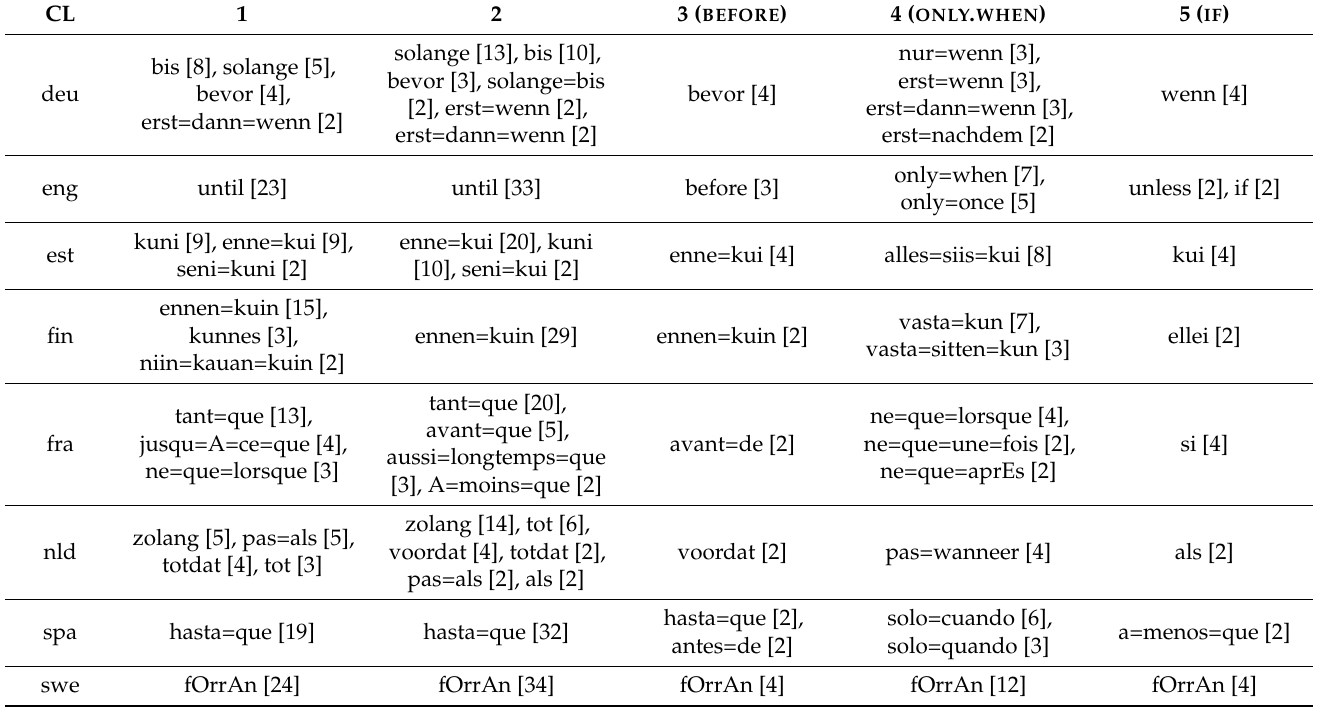
Table 7. Partitioning Around Medoids pam() with 5 clusters for selected languages.